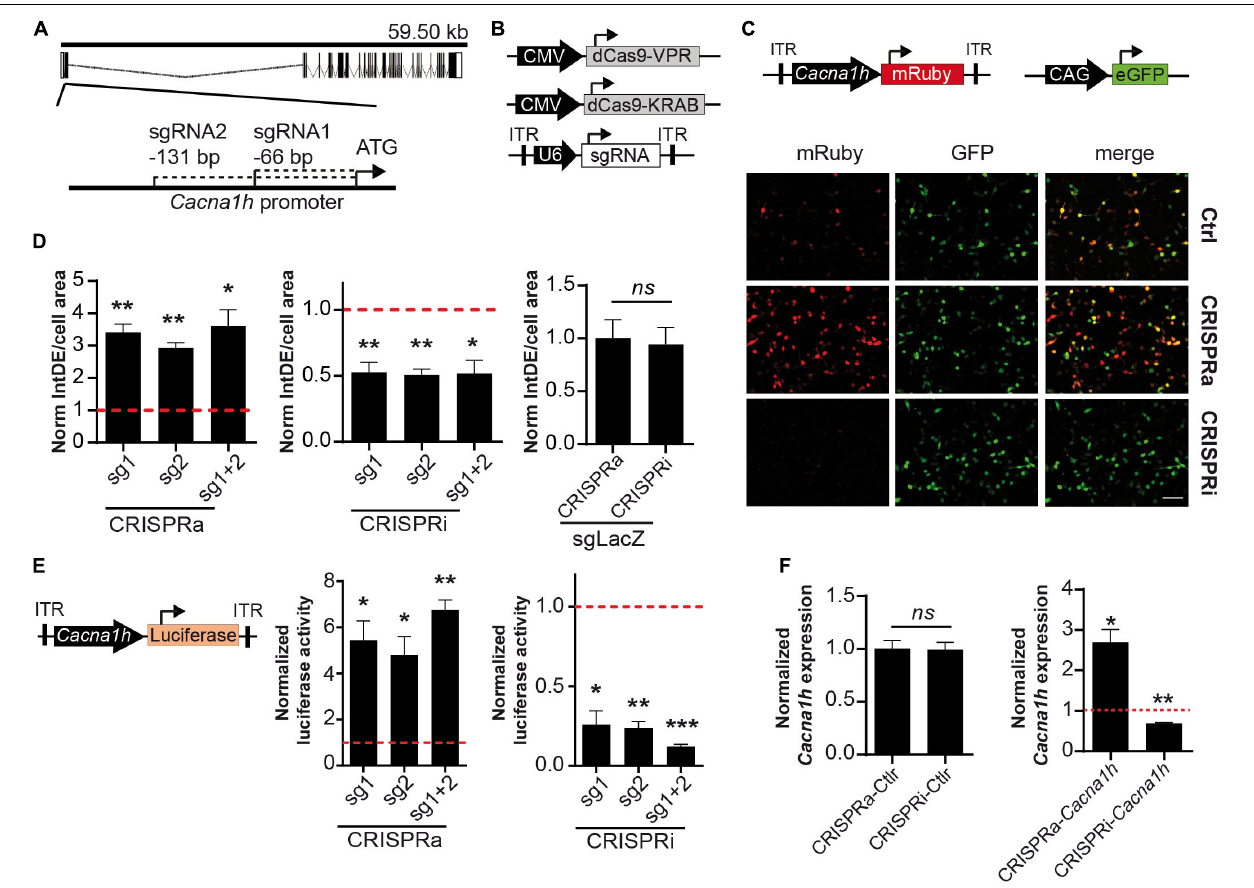
FIGURE 1 | Validation of the CRISPRa/i system for modulating Cacna1h expression. (A) Schematic representation of the Cacna1h mouse gene. Exons and introns are shown as boxes and dash lines, respectively. The position of sgRNA1 and sgRNA2 are indicated respective to the start-ATG (bp: base pairs). (B) Schematic illustration of the CRISPRa (CMV-dCas9-VPR), CRISPRi (CMV-dCas9-KRAB), and the sgRNA (pAAV-U6-sgRNA) constructs. (C) NS20Y co-transfected with CRISPRa or CRISPRi, the two sgRNAs targeting Cacna1h (or LacZ as control), the reporter pAAV- Cacna1h -mRuby, and a CAG-eGFP construct as internal control for transfection. Scale bar = 100 µ m. (D) Quantification of integrated density (IntDE) of mRuby per cell surface area (defined by CAG-eGFP positive cells). Values of IntDE/cell area were normalized to the controls of each treatment: CRSIPRa- LacZ for CRISPRa and CRISPRi- LacZ for CRISPRi (One sample t -test, N = 4), * p ≤ 0.05, ** p ≤ 0.01. (E) Luciferase activity of cells co-transfected with pAAV- Cacna1h -luciferase, CRISPRa or CRISPRi and sgRNAs targeting Cacna1h (or LacZ as control). Data normalized to each control: CRISPRa- LacZ for CRISPRa treatment and CRISPRi- LacZ for CRISPRi treatment (One sample t -test, N = 3), * p ≤ 0.05, ** p ≤ 0.01, *** p ≤ 0.001. (F) Cacna1h mRNA expression in NS20Y cells co-transfected with CRISPRa or CRISPRi. Left panel: Cells transfected with CRISPRa and CRISPRi without sgRNAs ( N = 3, t -test). Right panel: Cacna1h mRNA expression levels in NS20Y cells transfected with CRISPRa or CRISPRi and sgRNAs